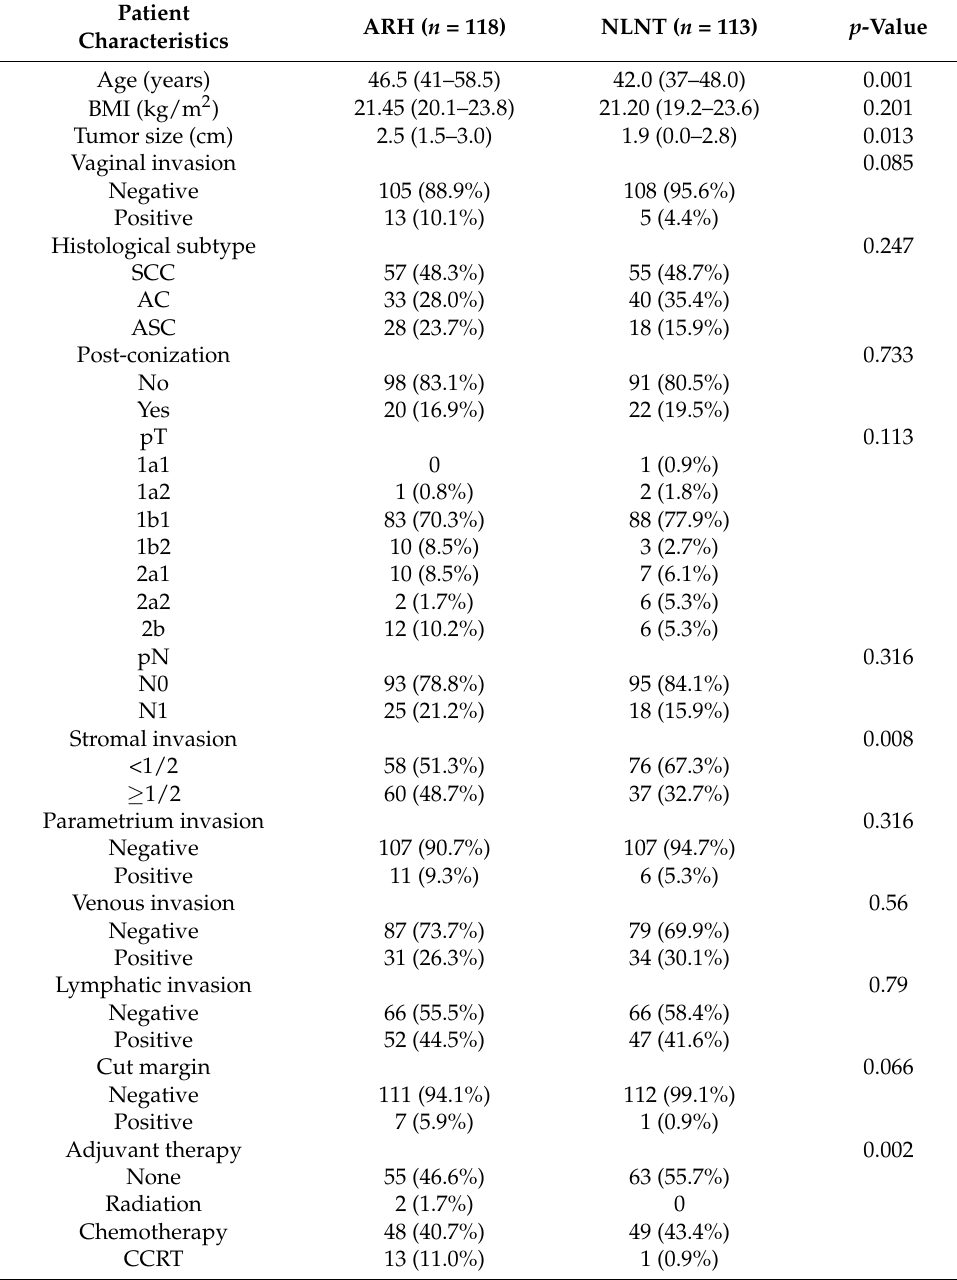
Table 1. Clinicopathologic characteristics of all